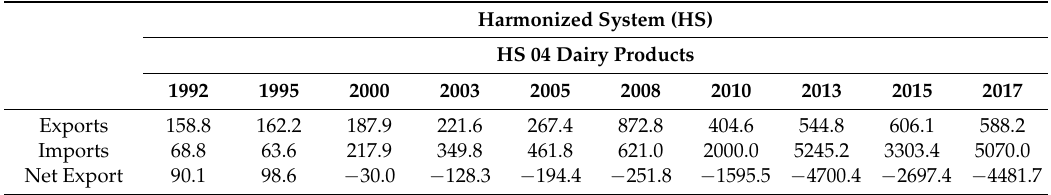
Table 1. Chinese dairy imports and exports (Unit: USD in Millions).